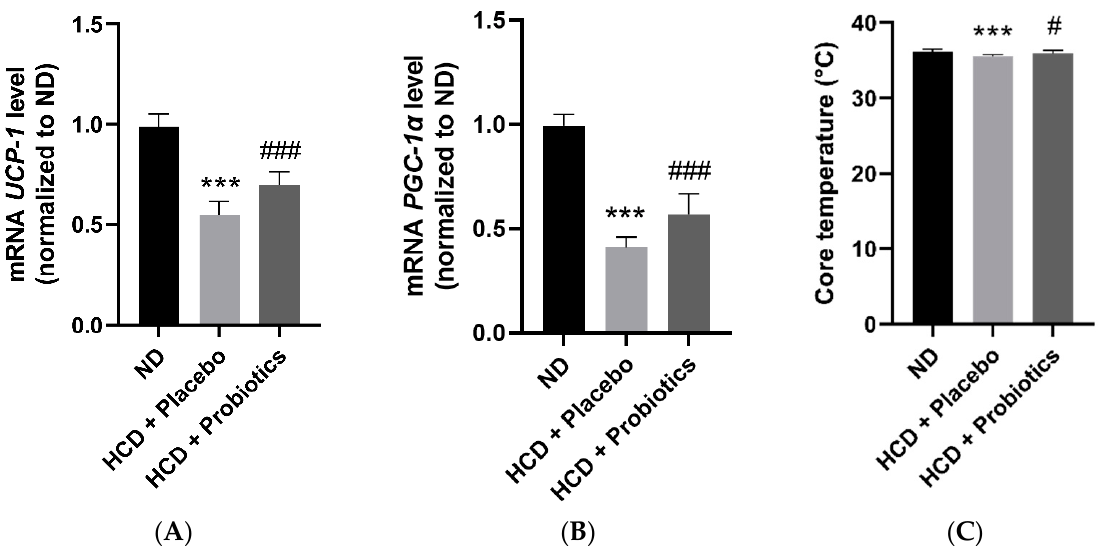
Figure 5. Effect of MSPs on thermogenesis in the visceral adipose tissues of HCD-fed mice. ( A , B ) mRNA expression of thermogenesis-related genes in visceral adipose tissues. ( C ) Core temperature of mice. Data are expressed as mean ± standard deviation ( n = 5 per group). *** p < 0.001 vs. ND; # p < 0.05 vs. HCD + placebo; ### p < 0.001 vs. HCD + placebo. Legend: HCD, high-carbohydrate diet; mRNA, messenger ribonucleic acid; MSPs, multi-strain probiotics; ND, normal diet; PGC-1 α , peroxisome proliferator-activated receptor- γ coactivator; UCP-1 , uncoupling protein 1.